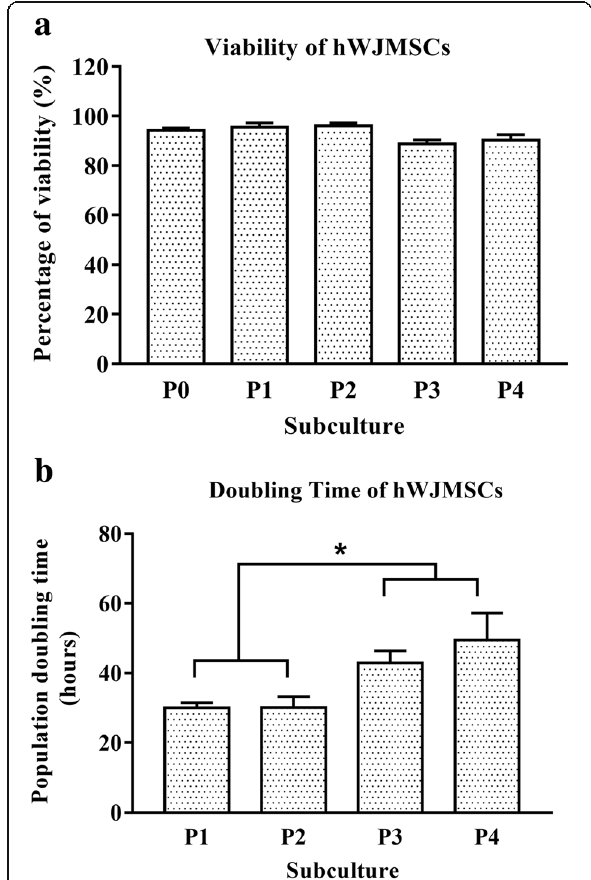
Fig. 2 Growth kinetic profile of hWJMSCs. a Percentage of viability of hWJMSCs. b Population doubling time of hWJMSCs from the initial passage (P0) until passage 4 (P4). * indicates a significant difference at p < 0.05 ( n = 3)